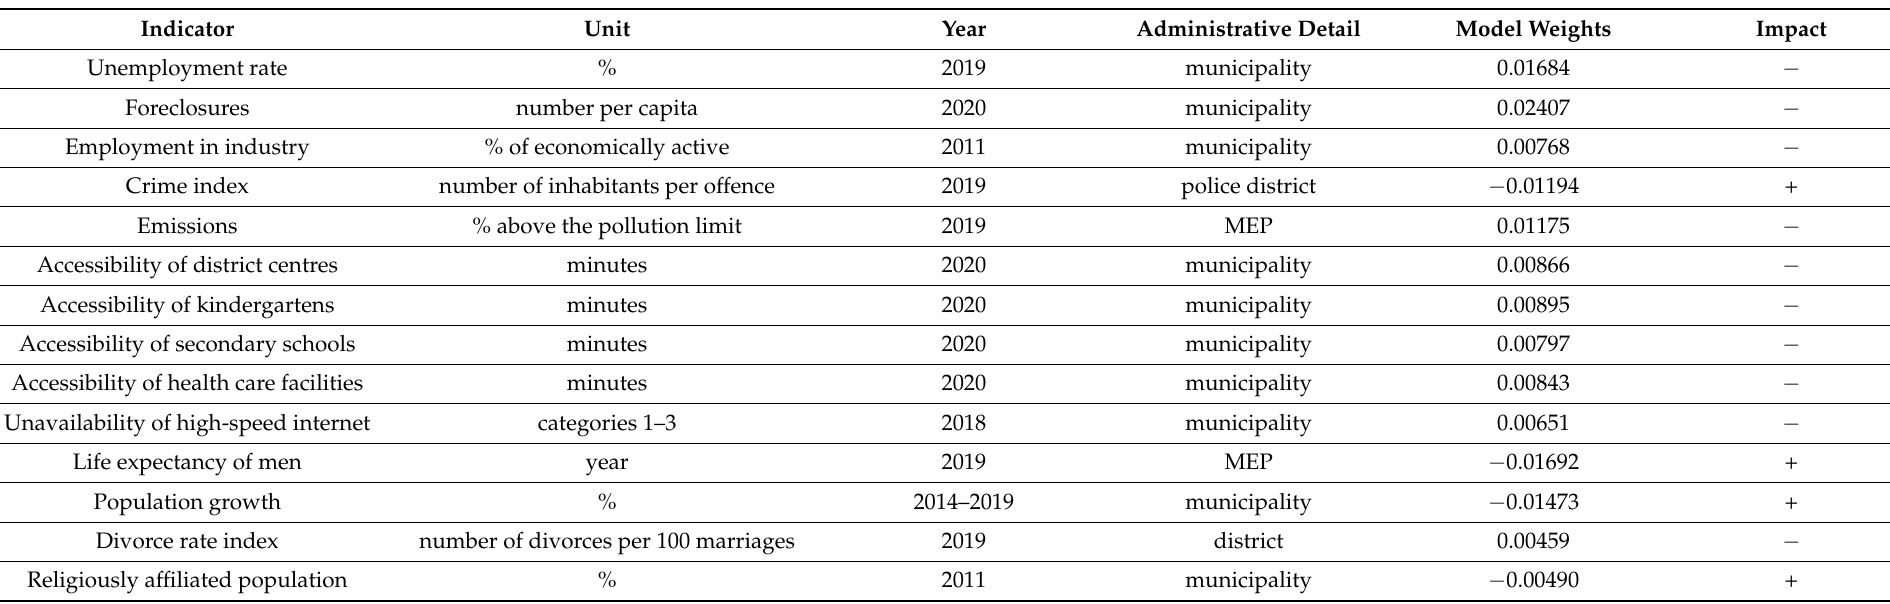
Table A2. Input indicators for the adjusted index: accessibility indicators recalculated using network